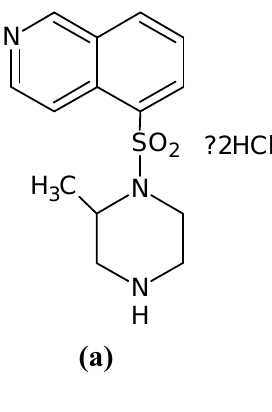
Figure 3. Chemical structures and names of the H-Series inhibitors. ( a ) H-7 hydrochloride, 1-(5-isoquinolinesulfonyl)-2-methylpiperazine·2HCl; H-8 N-[2- aminoethyl)-5-isoquinolinesulfonamide; ( d ) H-89, N-[2-( p -bromocinnamylamino)ethyl]-5-